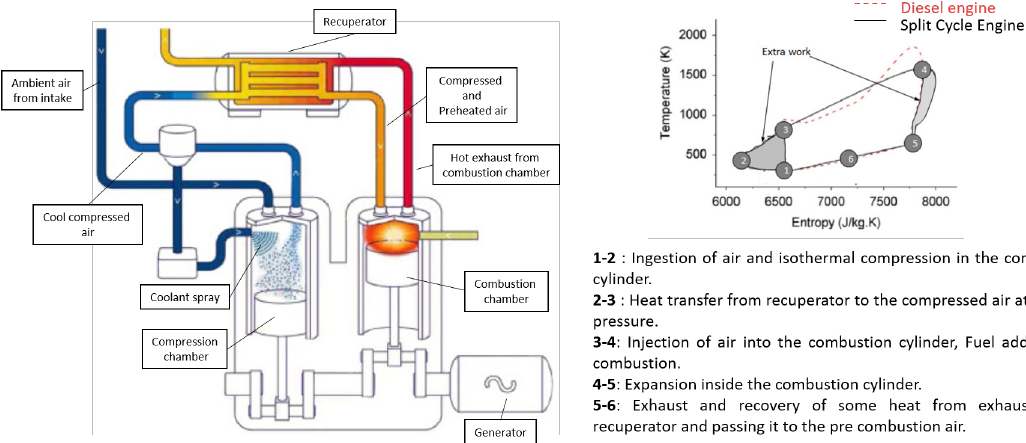
Figure 2. Schematic diagram of recuperated split cycle engine (RSCE) [16] ( left ) Temperature(T)–Enthalpy (S) diagram of the RSCE against that of a diesel engine by Morgan [14] ( right